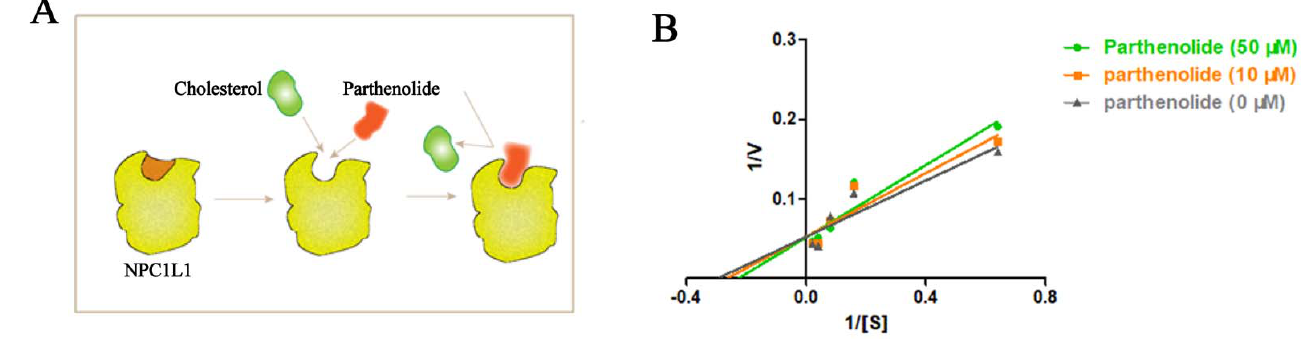
Figure 5. ( A ) Competitive inhibition mechanism of PTL. ( B ) Lineweaver − Burk plot in the presence of PTL at different concentrations.